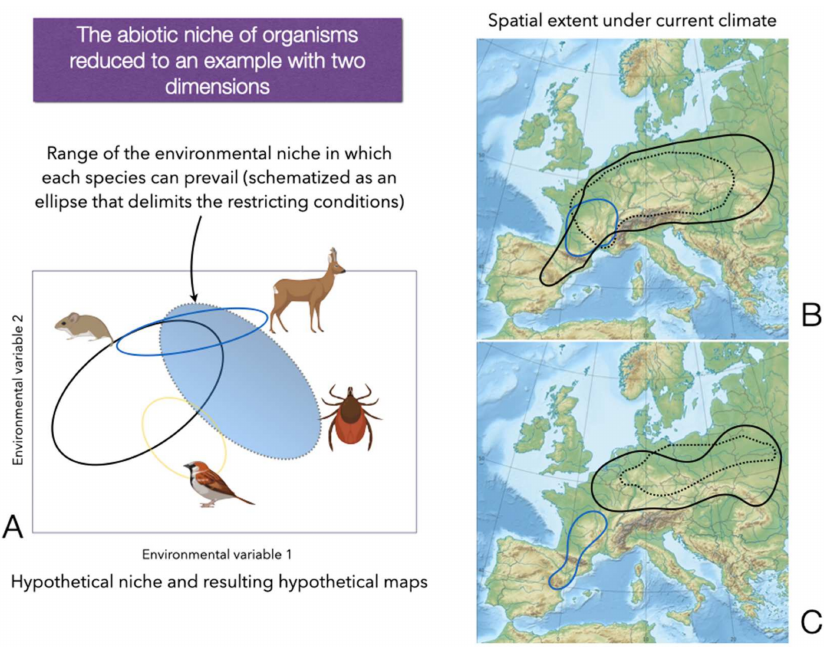
Figure 2. Representation of the concept of “environmental niche”. We illustrate ( A ) a simplified representation of the hypothetical environmental niches of one species of tick and several species of vertebrates, with only two hypothetical variables (axes X and Y). In this view, organisms could have permanent populations in the area inside each ellipse, which “delimits” the area of suitable traits. Areas of overlap among ellipses correspond to areas of “niche overlap” or habitat sharing without geographical barriers. The shared area is thus proportional to the contact rates of a tick with different vertebrates. The suitable niche is commonly translated into maps displaying por- tions that could fit inside these suitable conditions according to the current climate (contours in ( B )) or using scenarios of the future climate (hypothetical illustration in ( C )). Parts of the illustra- tion were created with BioRender.com. Original map of Europe downloaded under licence CC from Wikipedia (https://commons.wikimedia.org/wiki/File:Europe_relief_laea_location_map.jpg accessed on 12 March